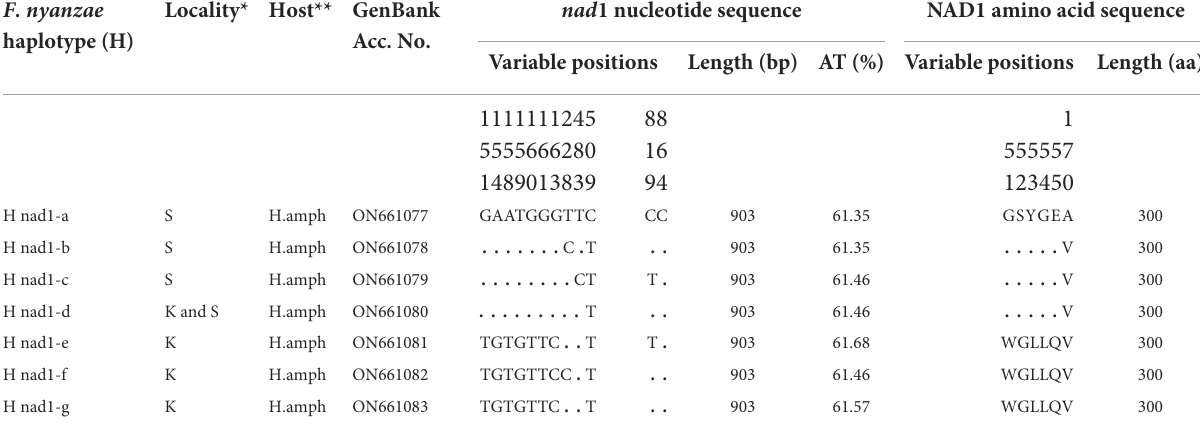
TABLE 7 Nucleotide and amino acid differences found in the complete mtDNA nad 1 sequence of Fasciola nyanzae from South